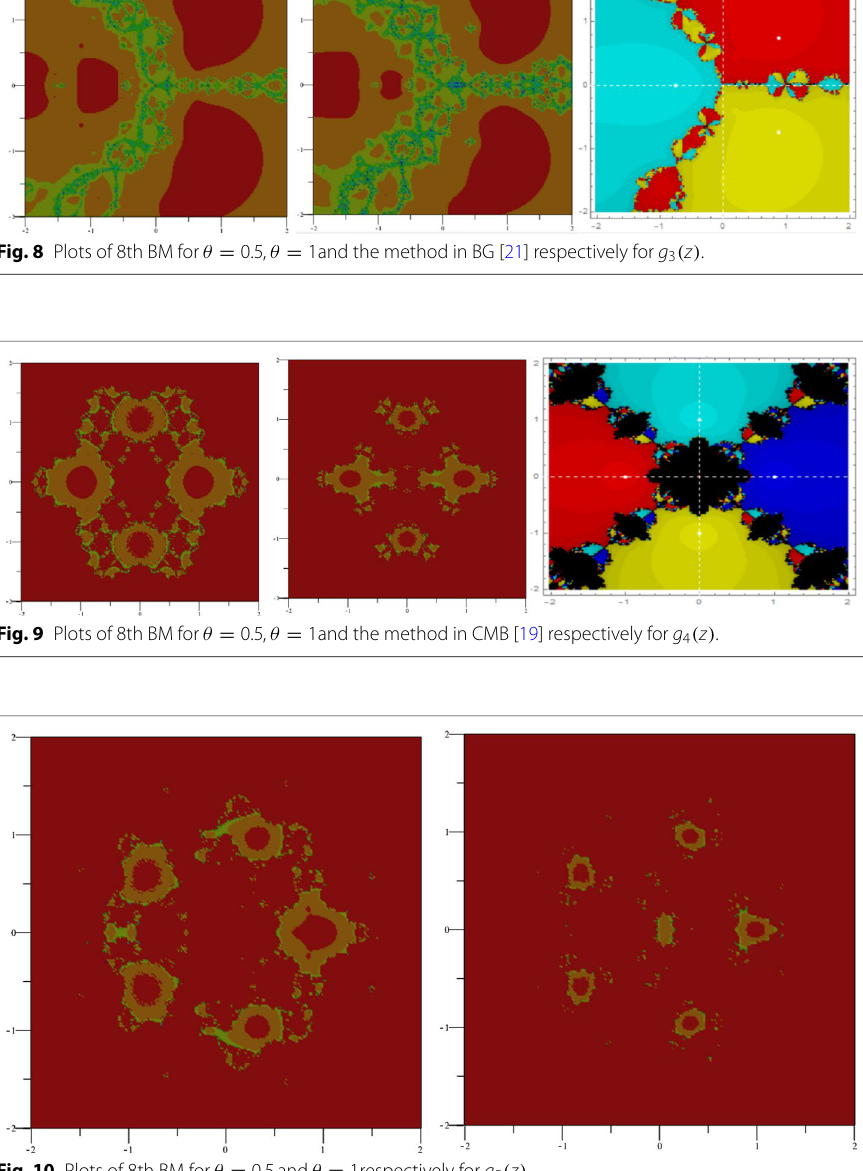
Fig. 10 Plots of 8th BM for θ = 0.5 and θ = 1 respectively for g 5 ( z )